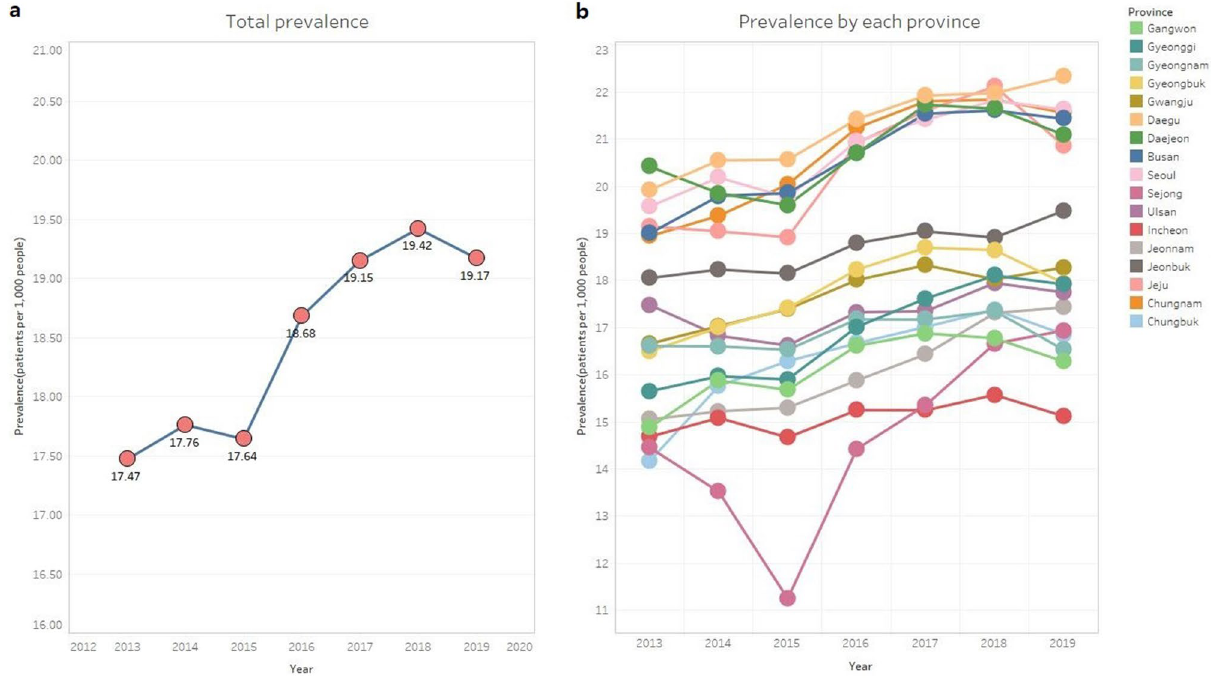
Figure 1. Prevalence of conjunctivitis. ( a ) Prevalence of conjunctivitis by year (number of patients per 1,000 people). The number of patients increased from 2013 to 2019. ( b ) Prevalence by each